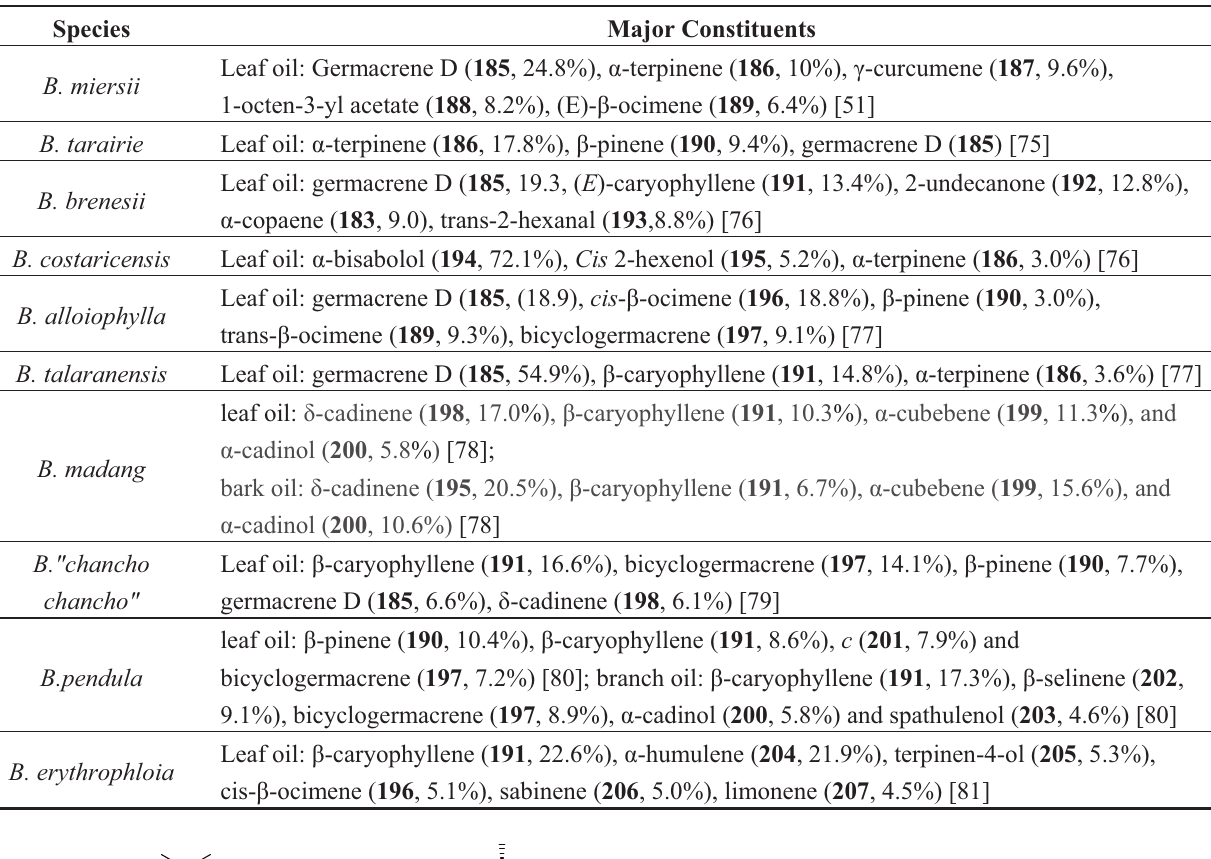
Table 4. Chemical composition of essential oils of Beilschmiedia species. Species Major